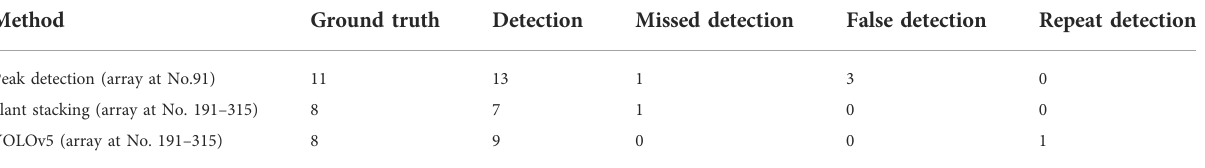
TABLE 1 Vehicle detection veri fi cation. Method Ground truth Detection Missed detection False detection Repeat detection